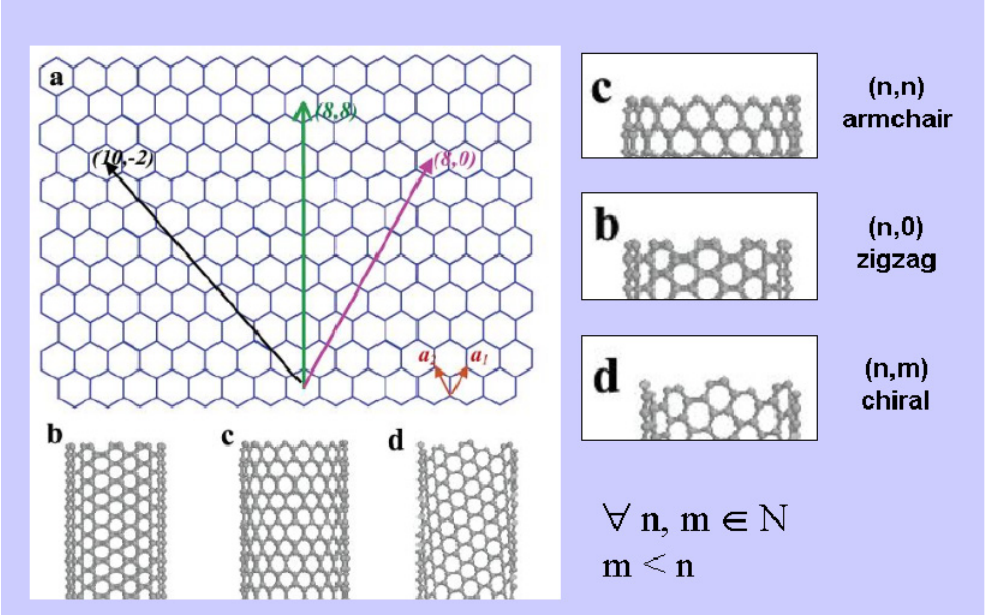
Figure 3. Representation of different NT configurations and associated